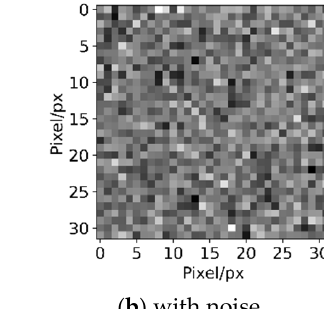
Figure 12. The grayscale images before and after adding noise with SNR = 0 dB. Different noise levels were tested by adding Gaussian white noises with SNR ranging from −4 dB to 8 dB to the original datasets described in Table 1. Then, the noise−added grayscale images and vibration signals were used as the input of 2DCNN−RF, standard CNN, LSTM, BPNN and SVM, so that their noise-resistive fault-diagnosis performance could be evaluated and compared. Figure 13 shows the fault-diagnosis accuracy of the five fault-diagnosis models. In comparison with Figure 9, Figure 13 shows that the fault- detection accuracy was reduced for all fault−diagnosis methods by introducing the addi- tional measurement noises, which means a high noise level will pose a risk of fault-detec- tion failure. Moreover, it can be observed that the fault-diagnosis accuracy will decrease with increasing noise intensity for all methods, and the noise impact on machine-learning methods is more significant than that of deep-learning methods. Still, the proposed 2DCNN−RF has better accuracy than the other four models. Under noise condition SNR = −4dB, the diagnostic accuracy of the 2DCNN−RF model still reaches 80.26%, which is 5% higher than that of the standard CNN and LSTM models. The accuracy of machine learn- ing methods, namely BPNN and SVM, is only about 10%. These evaluation results demon- strate that the proposed 2DCNN-RF fault-diagnosis strategy is more robust against noise pollution for high-speed bearing-vibration signals.